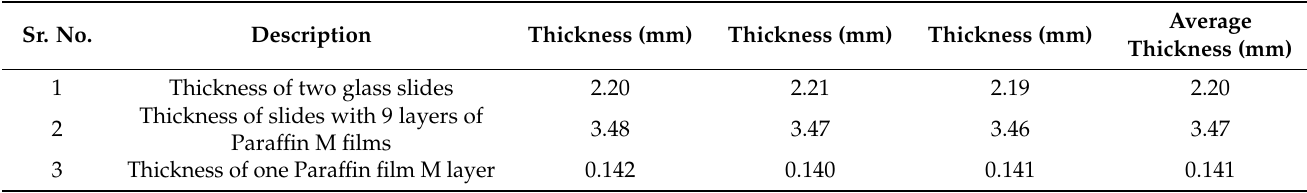
Table 2. Thickness results of Parafilm M